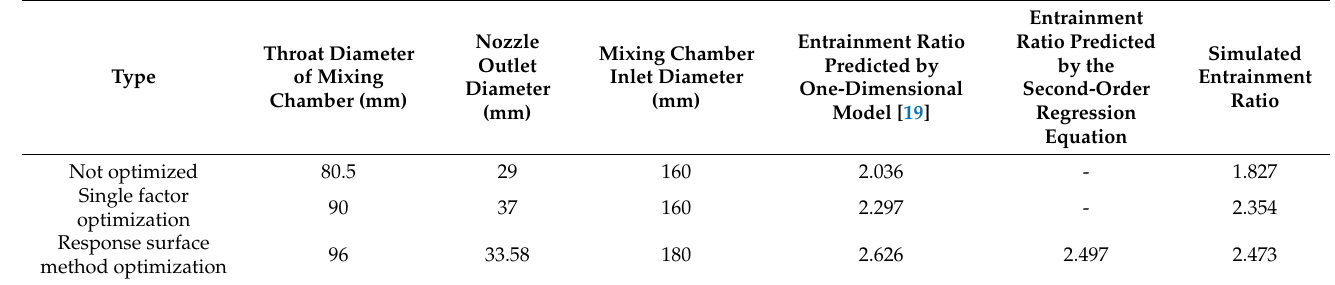
Table 8. Comparison of the three main influencing factors of the ejector under different optimization methods.